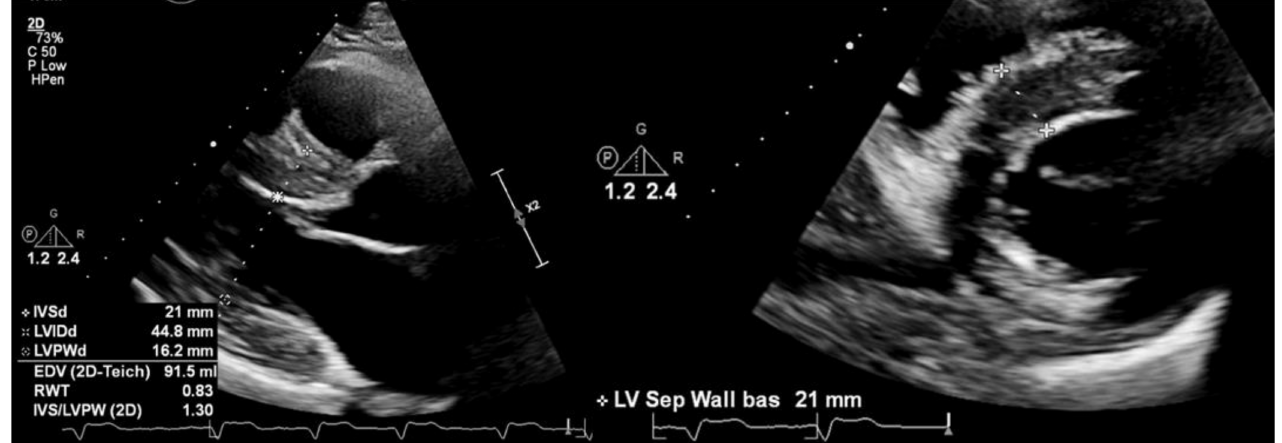
Figure 1. ( Left ) Parasternal long axis 2D TTE demonstrating linear measurements of IVS, LVID and LVPW demonstrating severe LVH; ( Right ) Parasternal short axis 2D TTE demonstrating severe LVH with MWT of 21 mm. Both images are taken from an adult male with advanced cardiomyopathy related to FD.